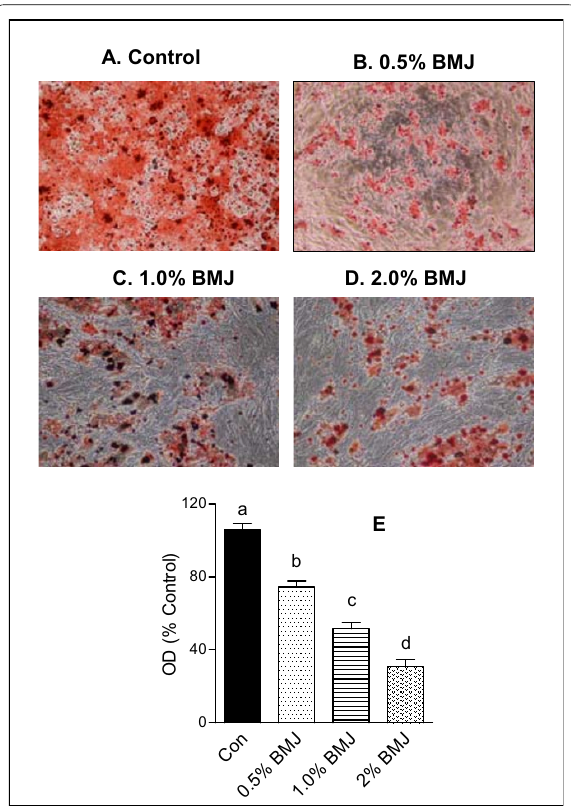
Figure 2 Effect of bitter melon juice on cellular lipid droplets . To- tal cellular lipid contents were significantly reduced in preadipocytes undergoing differentiation when treated with varying concentrations of BMJ (Figures 2A - 2C). Light microscopic pictures of oil red 'O' stain- ing in untreated control adipocytes (A), and preadipocytes treated with - 0.5% BMJ (B), 1% BMJ (C) or 2% BMJ (D), during differentiation (40× magnification). Figure 1E depicts degree of preadipocyte differ- entiation during treatment as measured by total amount of extracted oil "O" red. Values represent the mean ± SE (n = 6) of three indepen- dent experiments conducted in duplicate. a, b, c, d Mean values with common letters do not differ (p <